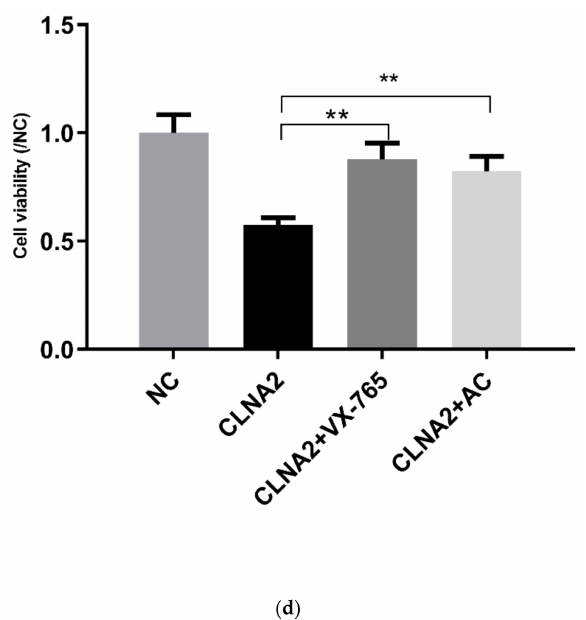
Figure 6. CLNA1 and CLNA2 induce Caco-2 pyroptosis by di ff erent pathways. ( a , c ) The expression of proteins associated with pyroptosis in colon cancer cells treated by CLNA1 or CLNA2. ( b ) The e ff ects of caspase-1 inhibitor VX-765 and lipid peroxdation inhibitor VE on Caco-2 cells treated by CLNA1. ( d ) The e ff ects of caspase-4 / 5 inhibitor AC and lipid peroxdation inhibitor VE on Caco-2 cells treated by CLNA2. a, b, and c indicate parallel tests. NC indicated control group without CLNA treatment. Data are presented as mean ± SEM and at least three separate experiments were performed in all studies. * p < 0.05, ** p < 0.01, and *** p < 0.001 compared with